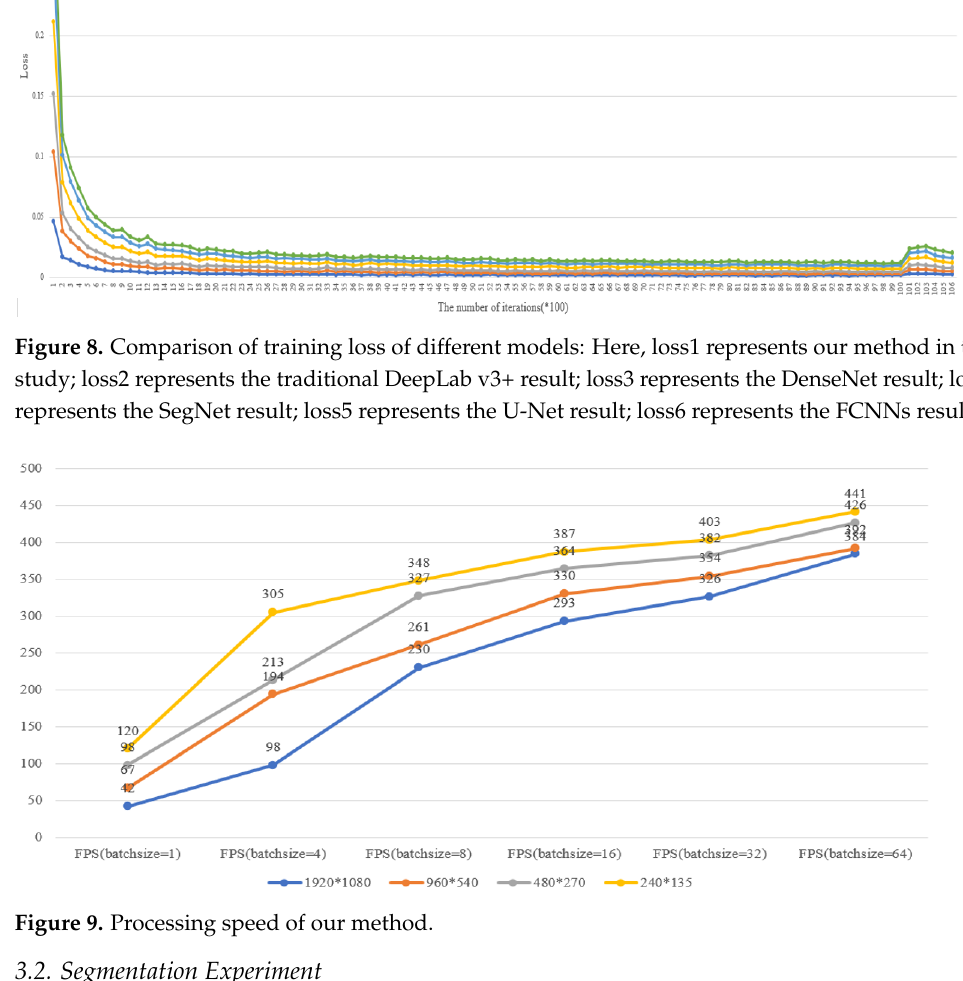
Figure 9. Processing speed of our